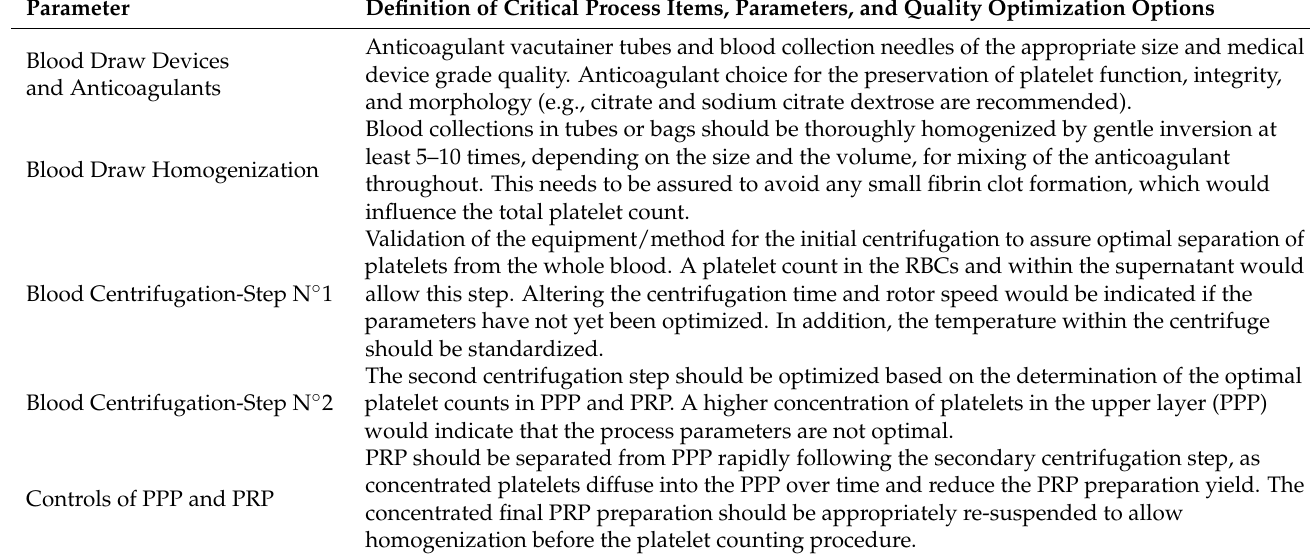
Table 3. Key manufacturing and control parameters influencing PRP quality, as well as recommen- dations and possibilities for PRP quality optimization. PPP, platelet-poor plasma; PRP, platelet-rich plasma; RBC, red blood